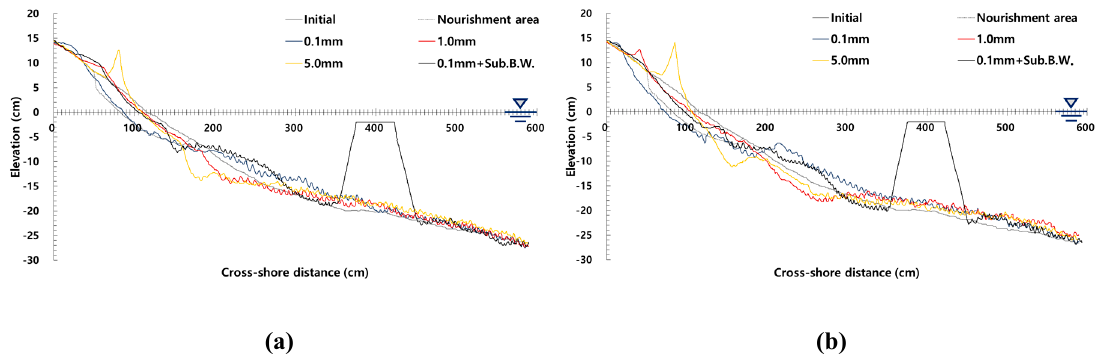
Figure 9. Comparison between sediment transport results and beach profile types. ( a ) Wind velocity 0m/s, ( b ) Wind velocity 8m/s.